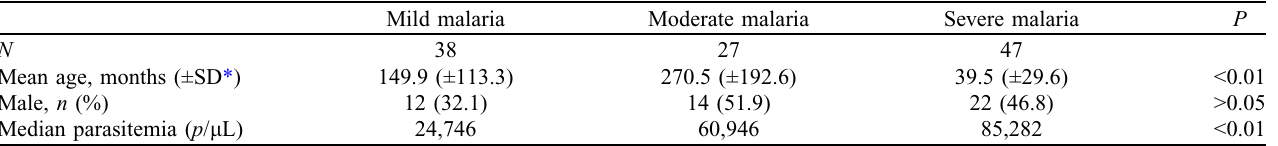
Table 1. Patients characteristics.